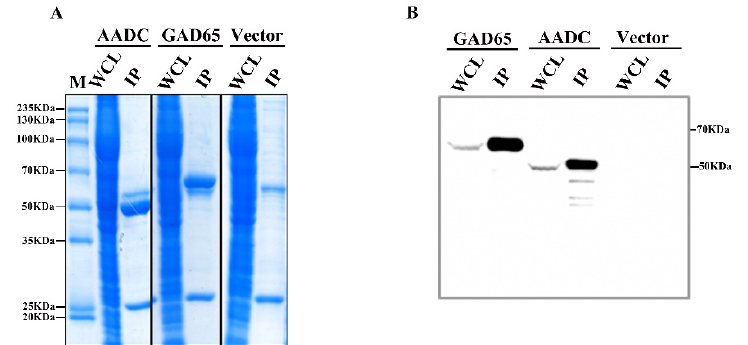
Figure 3. Expression and enrichment of GAD65 and AADC. ( A ) Plasmids Vector, FLAG-AADC, and FLAG-GAD65 were each transfected into HEK 293T cells. After 36 h, the cells were collected, and the whole cell lysate (WCL) after centrifugation was immunoprecipitated with anti-FLAG beads. IP, immunoprecipitation. The WCL and IP samples were subjected to SDS–PAGE gel electrophoresis and stained. Lane M served as a protein marker. ( B ) The WCL and IP samples were detected by Western blotting, and the expression of the target proteins was detected by anti-FLAG antibody.